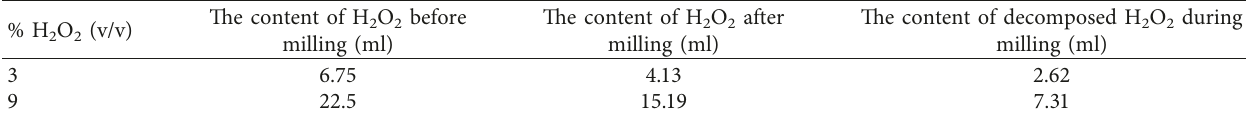
Figure 2: Morphology of HA scaffolds prepared from a 25% (v/v) suspension by freeze-casting: (a) and (b) water-based; (c) and (d) 3% (v/v) H 2 O 2 ; (e) and (f) 9% (v/v) H 2 O 2 . Table 1: The content of H 2 O 2 in the ceramic slurry before and after